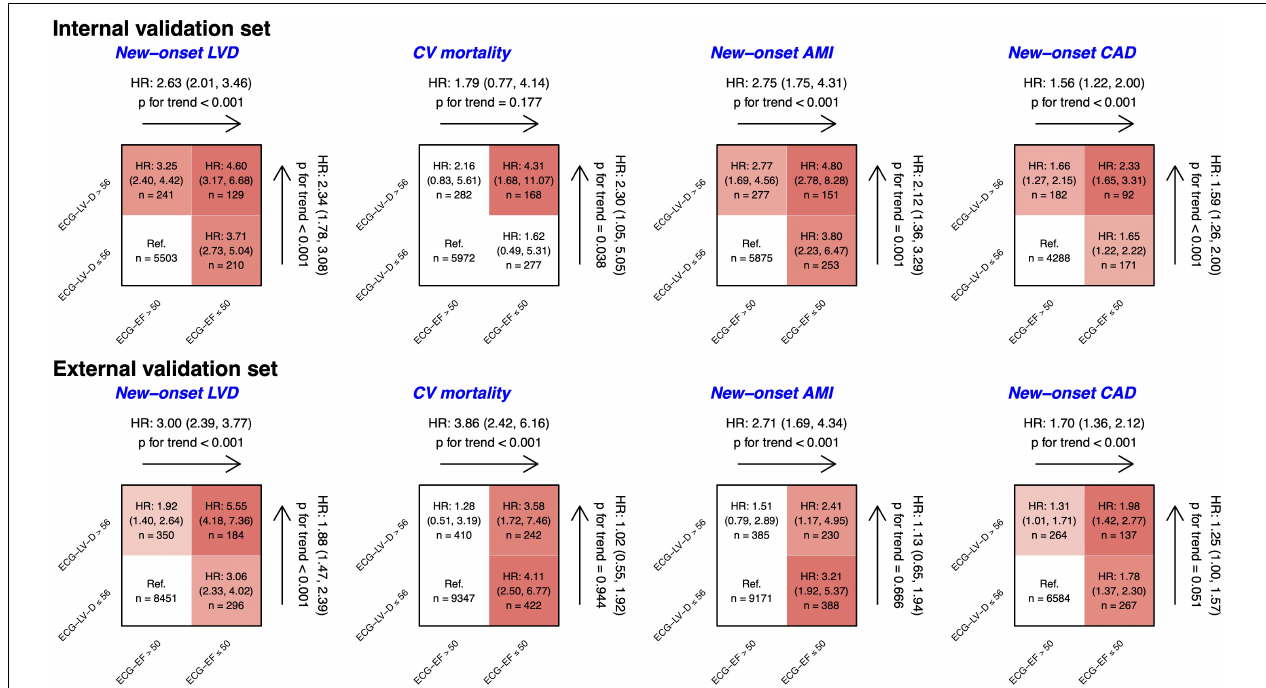
FIGURE 8 | Risk matrixes of different predicted ejection fraction (ECG-EF) and left ventricle (end-diastole) (ECG-LV-D) groups on adverse events in patients with an initially normal EF (EF > 50%). The hazard ratios ( HR s) are based on the Cox proportional hazard model adjusted by gender and age. The color gradient represents the risk of corresponding group, and the non-significant results are defined as